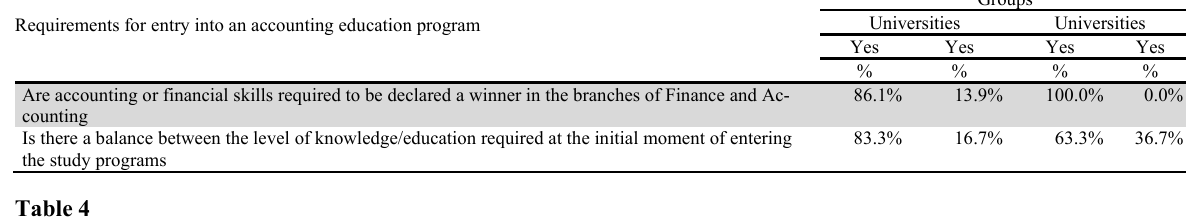
Professional skills